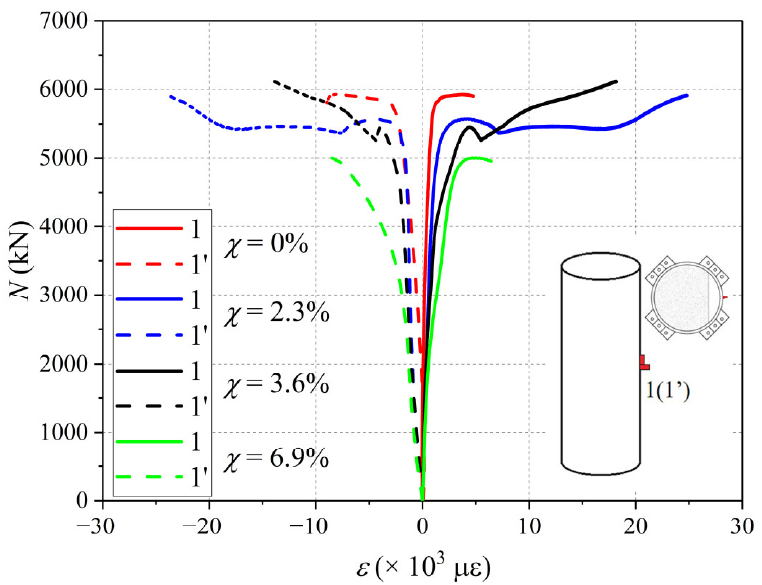
Figure 16. The N- ε curves at the gap part at a 1/2 height of the BWCFST specimens with spherical-cap gap with different χ .